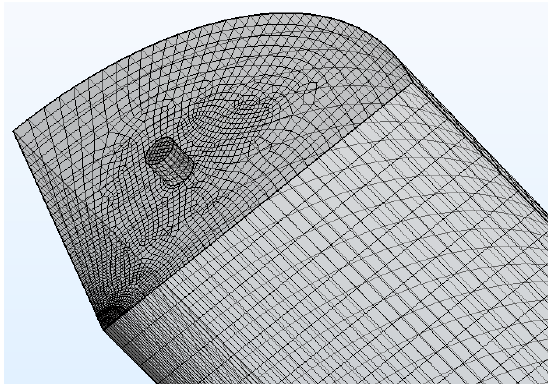
Figure 25. Meshing of the top section for a quarter of Reactor 2.